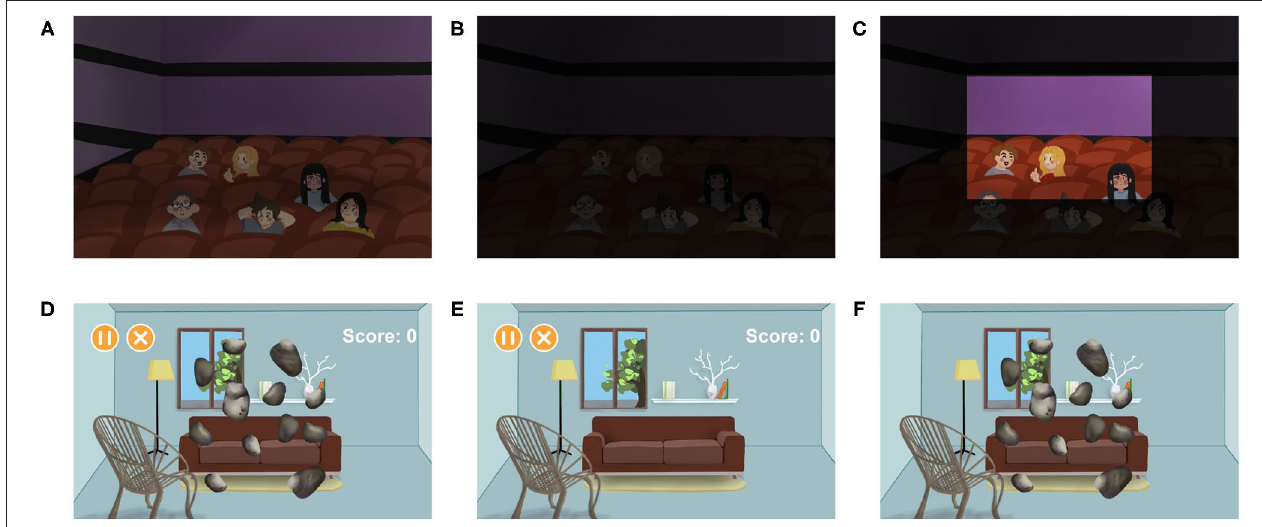
FIGURE 5 | Aiding patients with amblyopia and nyctalopia. (A–C) Illustrate aiding patients with nyctalopia (48). (A) The healthy vision. (B) The vision of patients with nyctalopia. (C) The vision of patients with nyctalopia after using the AR systems. The part of the scene is brightened to help the patients. (D–F) Illustrate aiding patients with amblyopia (49). The patients are forced to use their lazy eyes more important than healthy eyes. In this case, patients play games that ask them to crush the roaming stones. (D) The binocular vision. (E) The vision of the healthy eye, containing the game menus that do not need too much attention. (F) The vision of the lazy eye, containing roaming stones that require high